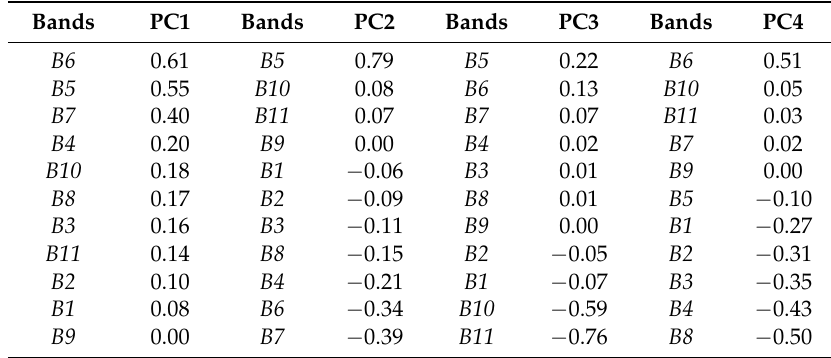
Table 3. First four principal components and respective eigenvectors.